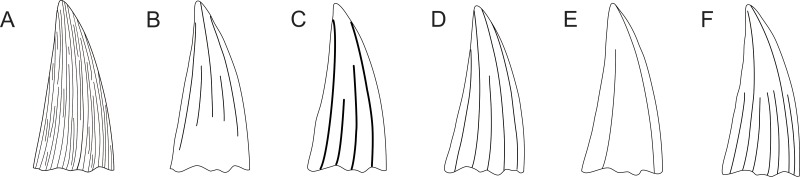
Pliosaurid tooth crown morphologies according to Tarlo (1960).Tooth crown morphologies as observed in Callovian pliosaurids and pictured in labial view by Tarlo (1960): (A) Simolestes nowackianus, (B) Simolestes vorax, (C) Liopleurodon ferox, (D) Liopleurodon pachydeirus, (E) Pliosaurus andrewsi, and (F) Peloneustes philarchus. S. nowackianus (Oxfordian or Kimmeridgian of Ethiopia) currently represents a species of the teleosaurid thalattosuchian Machimosaurus, M. nowackianus (Bardet & Hua, 1996; Young et al., 2014) and the assignment of andrewsi to Pliosaurus seems unlikely (e.g., Benson et al., 2013). All other combinations are in use.